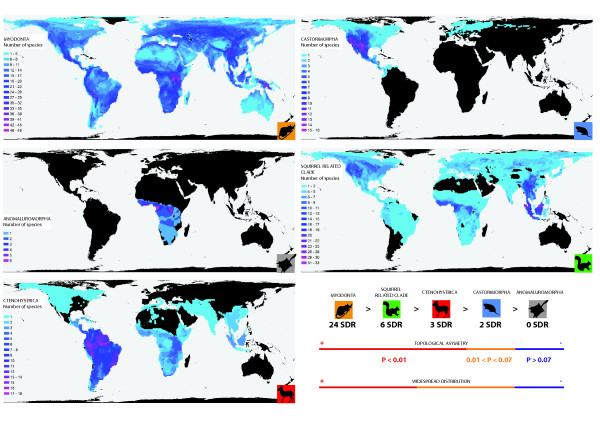
Current distribution maps of the major rodent clades. Color gradient represents species richness - a warmer color indicates higher richness. Black corresponds to areas where the group is not present. The maximum number of species in a cell (warmest color) for each clade is 49 (Myodonta), 16 (Castorimorpha), 6 (Anomaluromorpha), 33 (squirrel-related clade), and 18 (Ctenohystrica) respectively. Distribution width and topological asymmetry are indicated on the lower right part of the figure, together with the number of significant SDR (shifts in diversification rate).